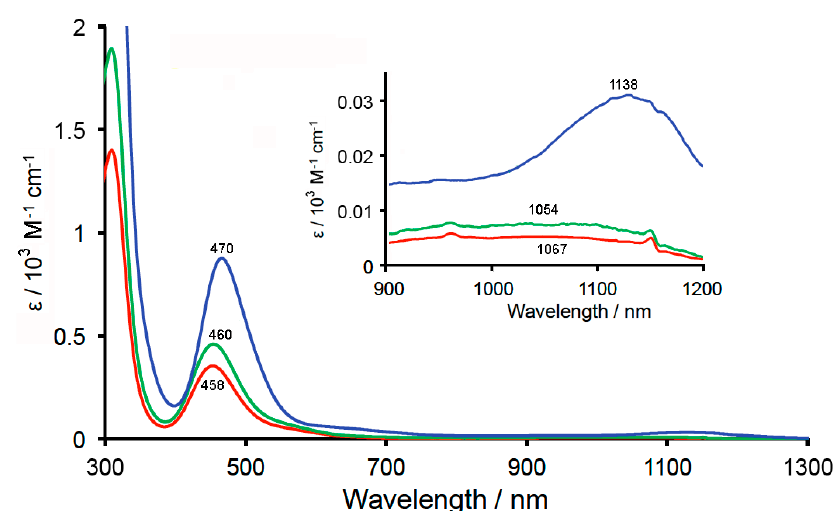
Figure 10. Absorption spectra (measured in CH 2 Cl 2 ) of 1 ( — ), 2 ( — ), and 3 ( — ).